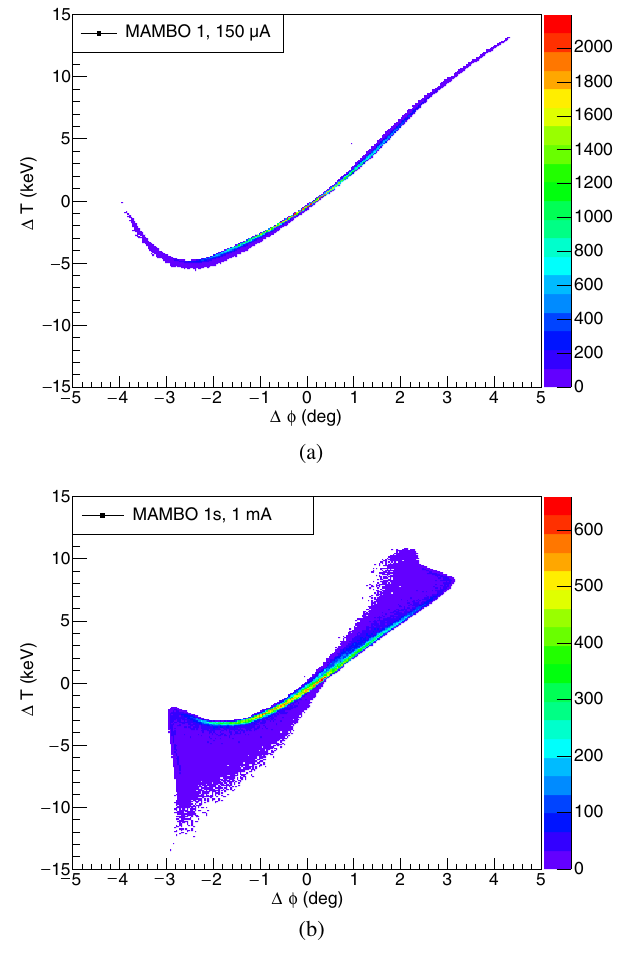
FIG. 3. Particle distributions in longitudinal phase space of different beam currents at the end of the first MAMBO RF- ¼ 1 mA the solenoids over MAMBO 1 were used section. At I b ¼ 10 mT (indicated by ’ s ’ in the legend of Fig. 3b). at B sol